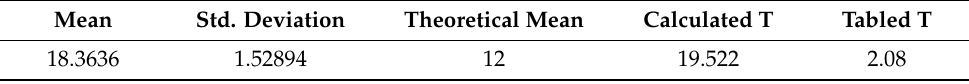
Table 10. The complete statistical analysis of the Efficiency